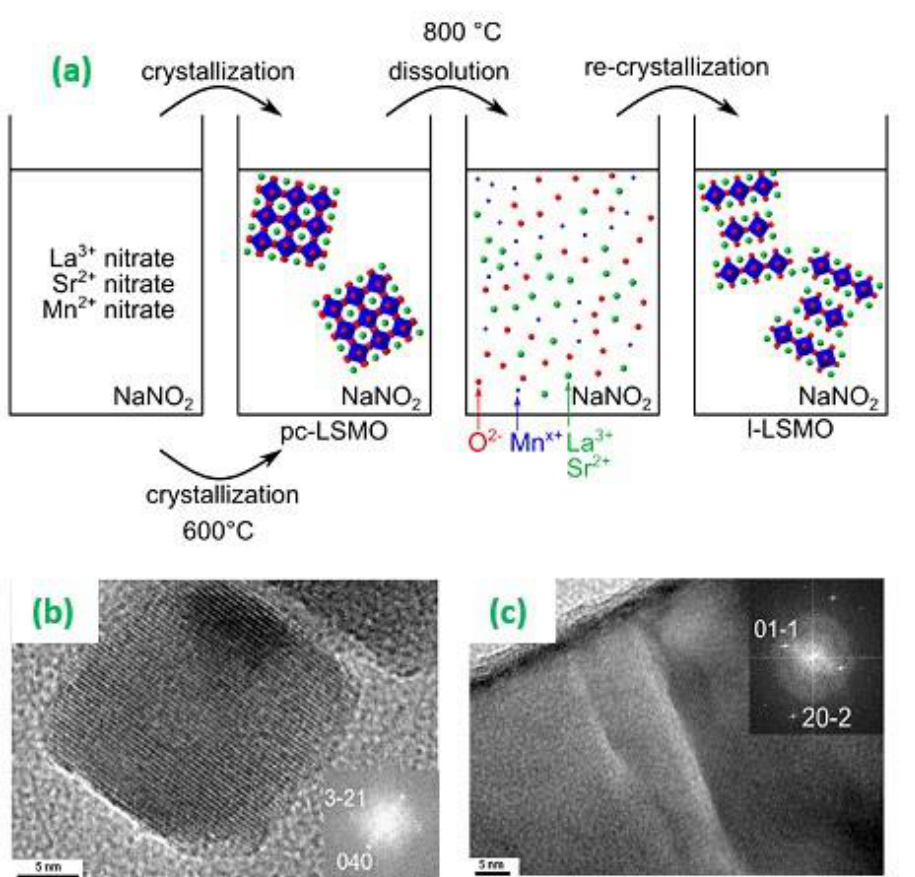
Figure 3. ( a ) Reaction pathway yielding layered perovskite (l-LSMO) nanoparticles from pc-LSMO into molten NaNO 2 , ( b ) HRTEM images of pc-LSMO nanocubes and ( c ) HRTEM image of an l-